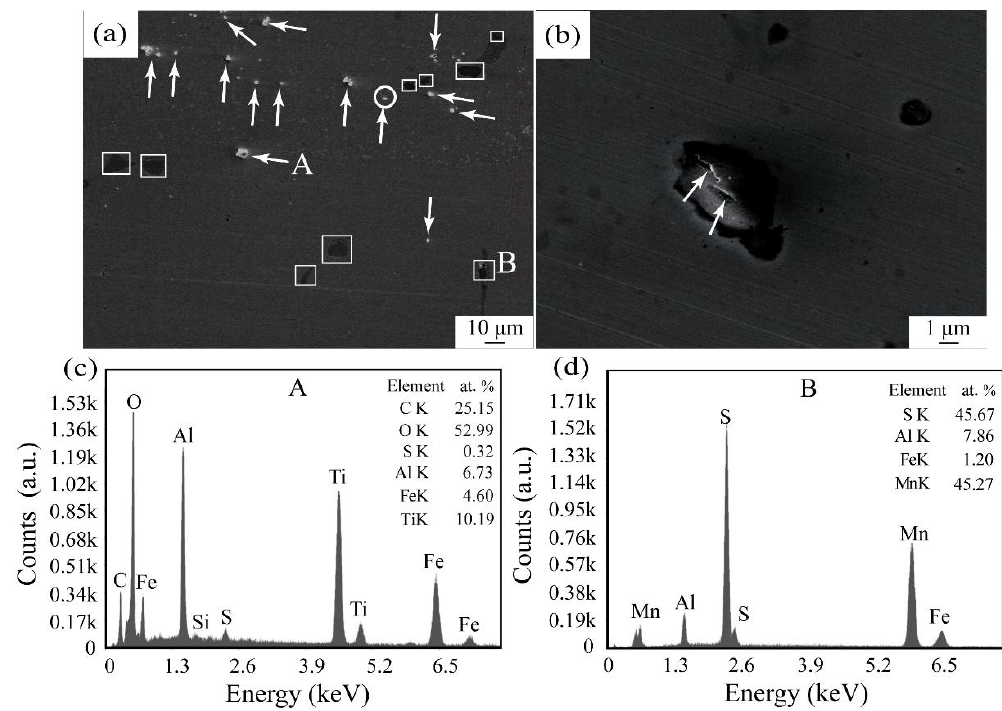
Figure 1. Distribution ( a ) of the oxide particles in the master alloy and EDX results of the points A and B in ( a ). ( b ) is the magnification to the circle in ( a ). ( c ), ( d ) are the EDX of the corresponding A, B particles, respectively.